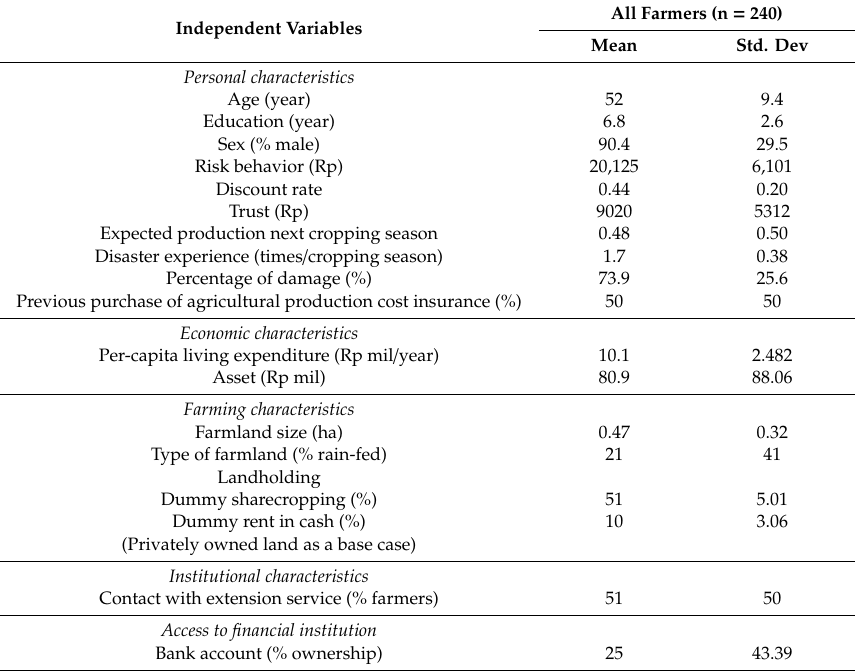
Table 2. Summary of farmers’